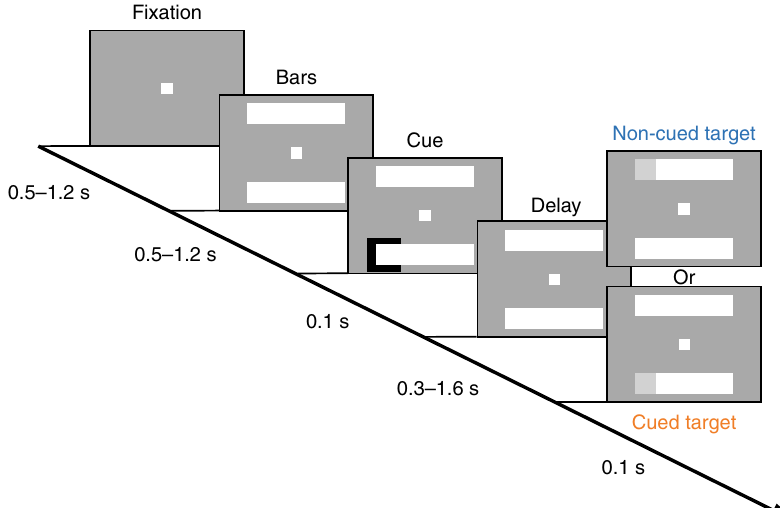
Fig. 2 A schematic of the behavioral task. The animals pressed a lever to begin each trial and maintained central fi xation. A spatial cue indicated, with 78% cue validity, where the visual-target was most likely to occur. Following a variable cue-target delay, a low-contrast visual target was either presented at the cued location or at a non-cued location. The animals responded by releasing the lever. We also included catch trials to track false